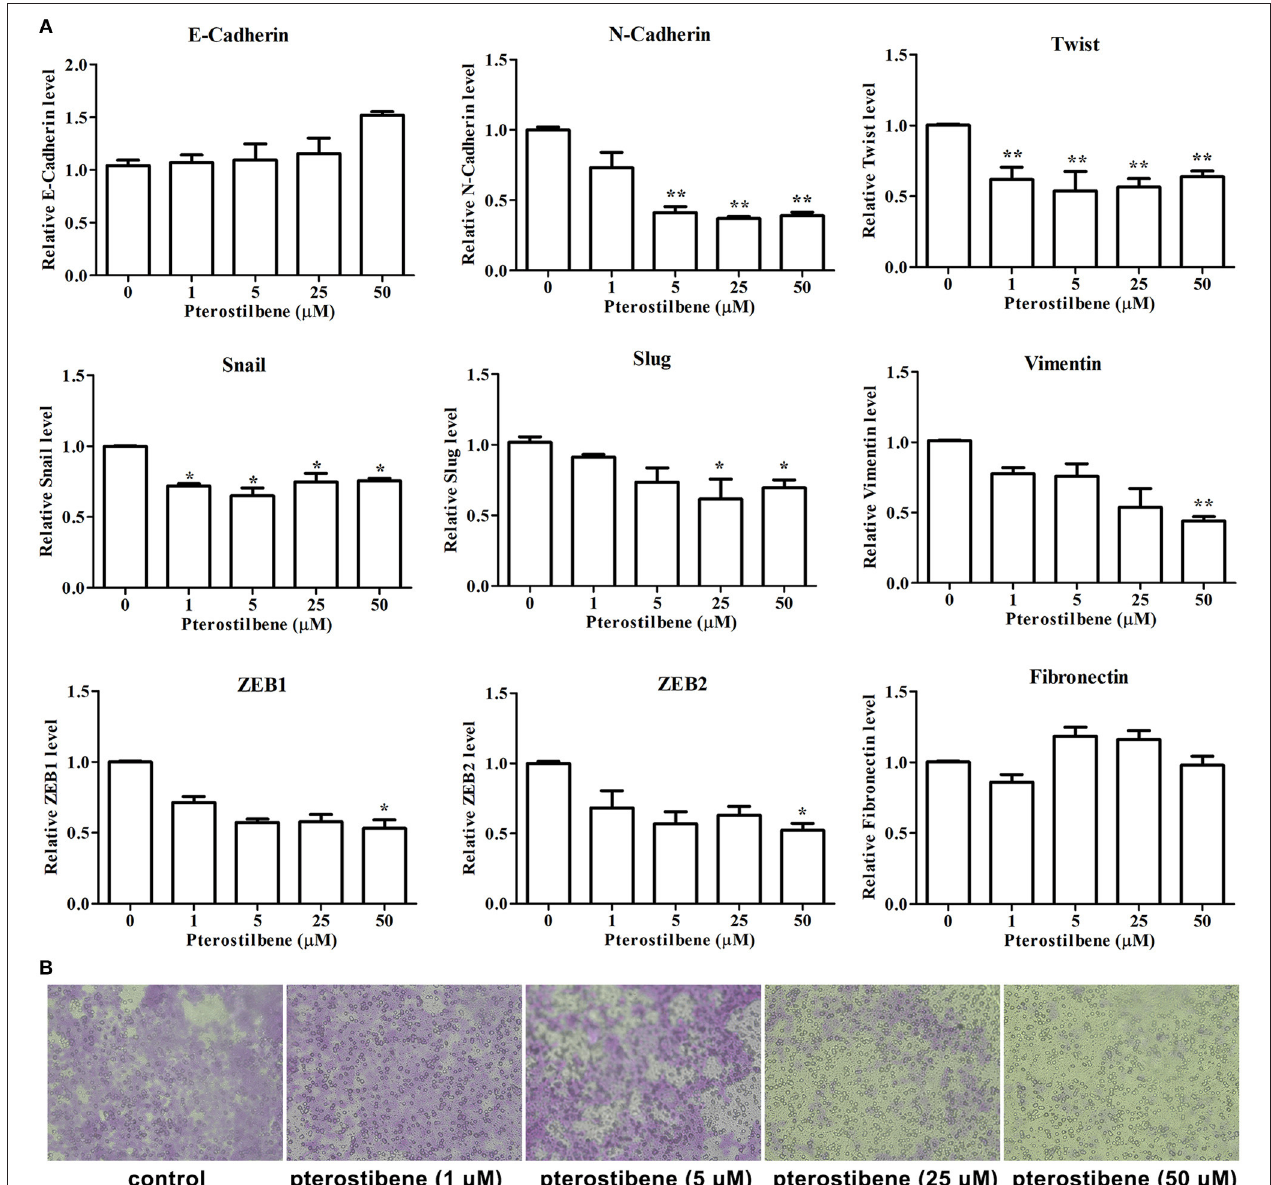
FIGURE 6 | Pterostilbene reduced EMT and migration. (A) Pterostilbene regulated the expression of EMT-related genes. Gene expression in cells treated with pterostilbene at different concentrations for 24h was calculated using qRT-PCR. Reported values are mean ± SEM. * p < 0.05 and ** p < 0.01, indicate significant differences compared with the control group. (B) Cell migration examined by Transwell